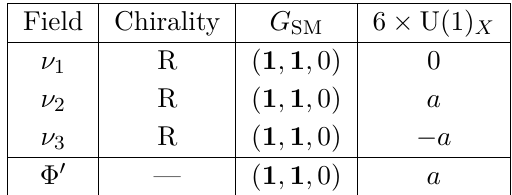
Table 2 . Additional fields (beyond the content of table 1) included in a variation of our model that can accommodate massive